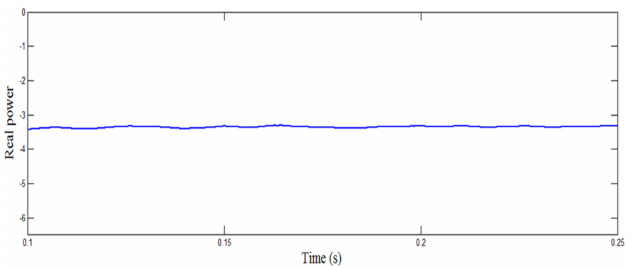
Figure 26. Real power from the bidirectional converter.